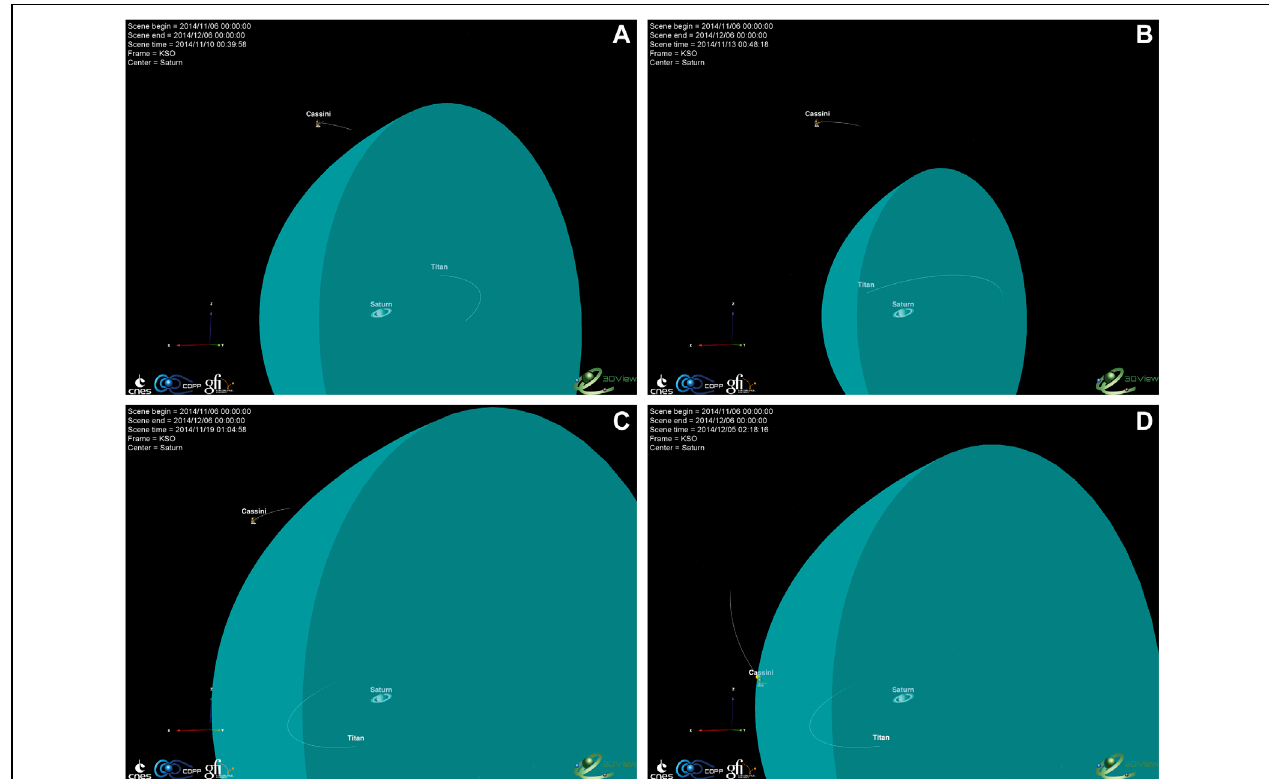
FIGURE 2 | Cassini trajectory with Saturn’s Magnetopause model (Kanani et al., 2010). Snapshots from 3Dview, at 00:00 on days 2014-11-10, 2014-11-13, 2014-11-19 and 2014-12-05, from (A–D), respectively. On panel (D) a marker shows the modelled reentry into the